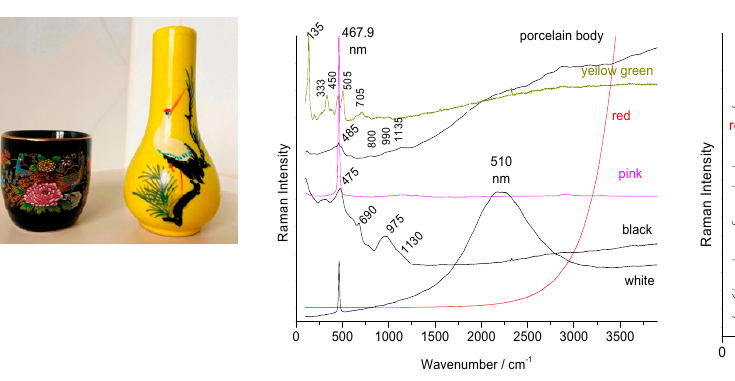
Figure 6. Representative Raman spectra and background recorded for two porcelains presented on the left, respectively made in Japan and Vietnam in the 1980s (see text).